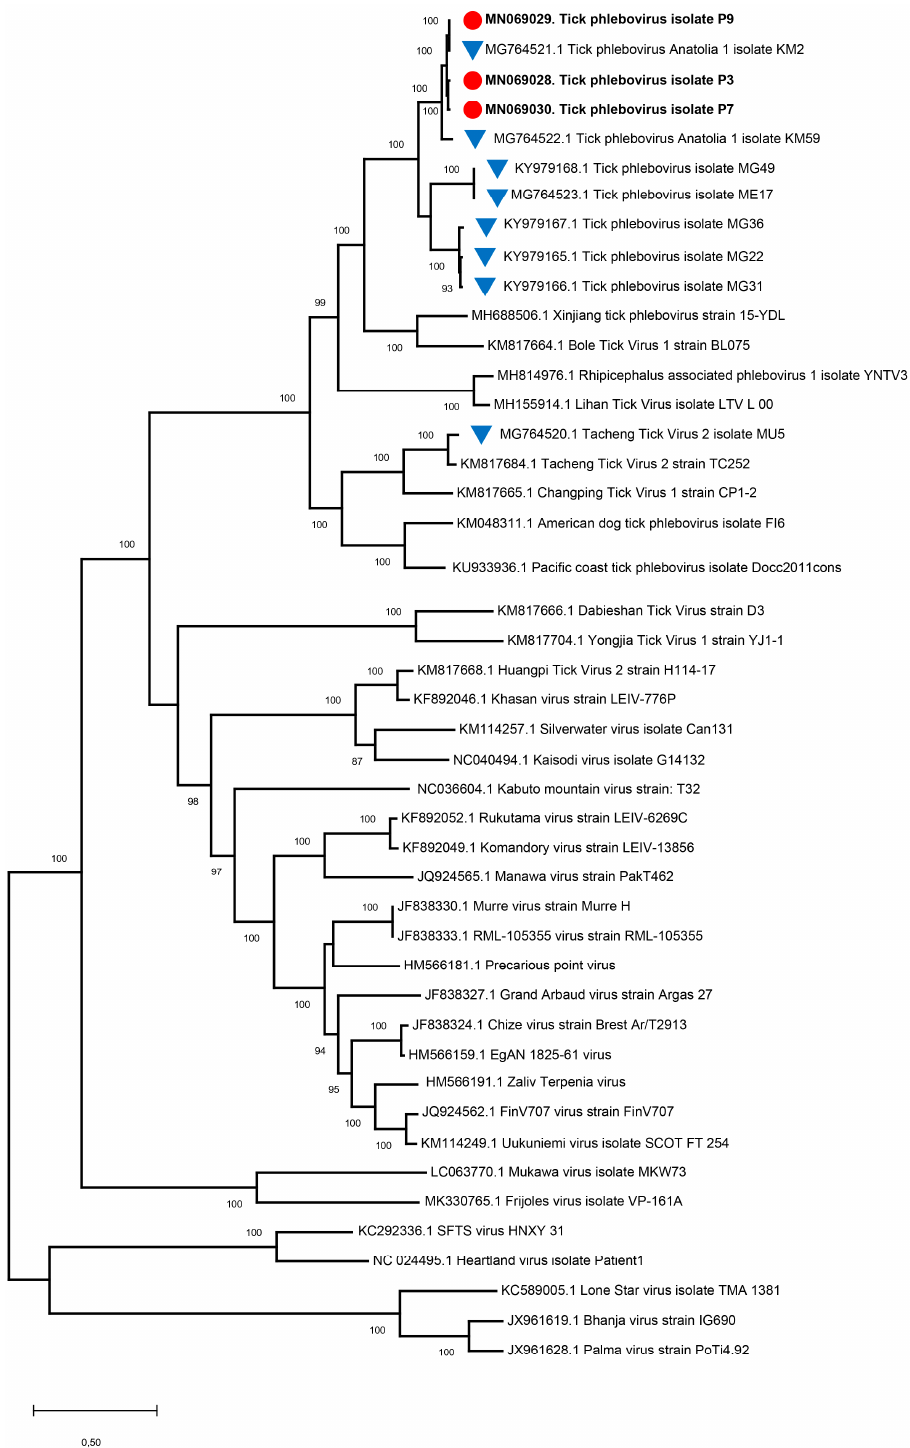
Figure 4. The maximum likelihood analysis of the L segment near-complete coding sequences of tick phleboviruses (4642 bp). The tree is constructed using the General Time Reversible (GTR) model, Gamma distributed with Invariant sites (G + I) for 500 replications. The sequences characterized in this study are given in bold and indicated with a symbol (red circle), GenBank accession number, and pool code. Global virus strains are indicated by the GenBank accession number and strain / isolate name. Viruses previously characterized in Turkey are indicated with a blue triangle. Bootstrap values higher than 80 are